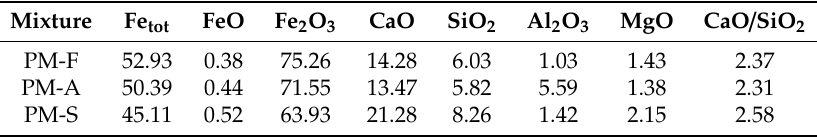
Table 3. Predicted chemical composition of the powder mixtures,